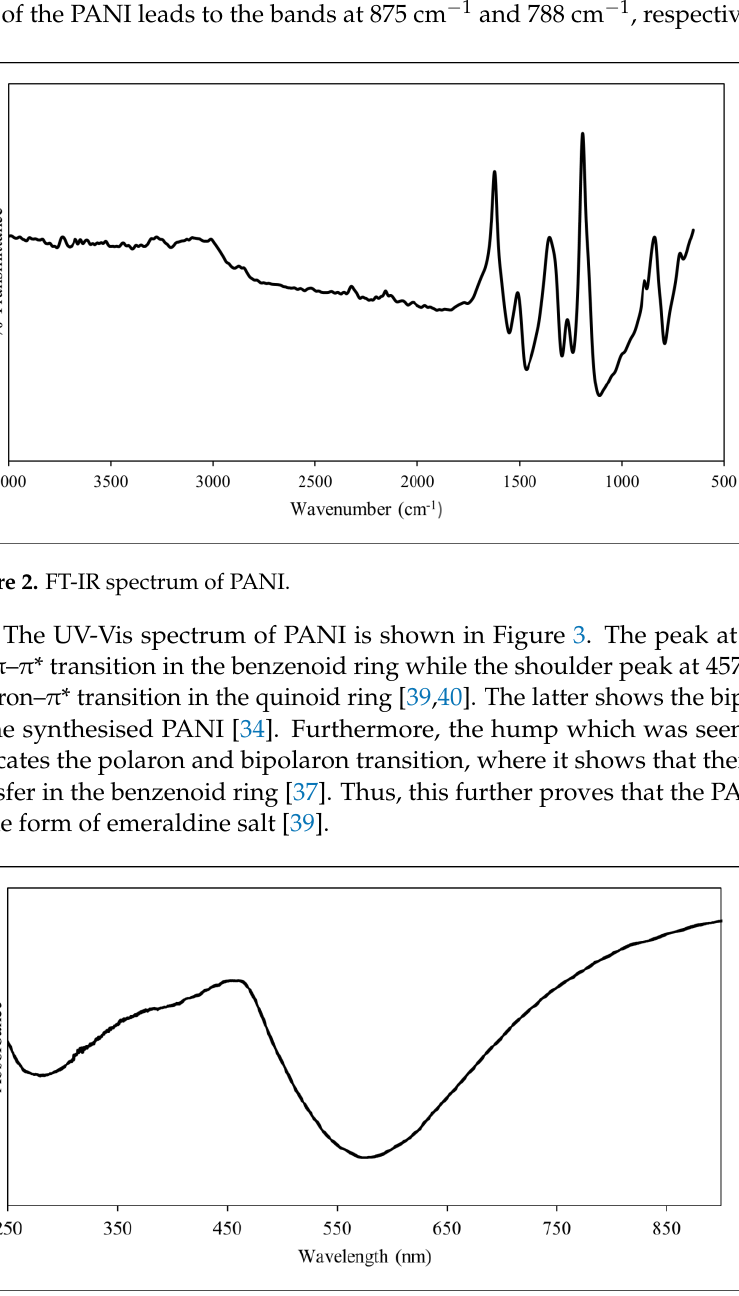
Figure 3. UV-Vis spectrum of PANI.